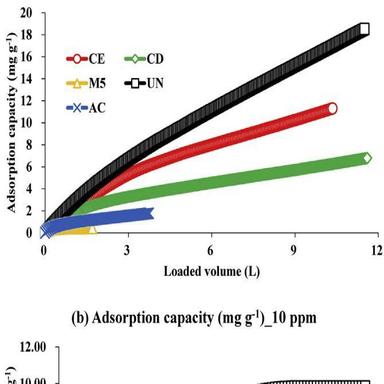
Adsorption capacities of the tested adsorbents toward high FA concentrations (5–25 ppm) (ambient temperature and 2 mg adsorbents).